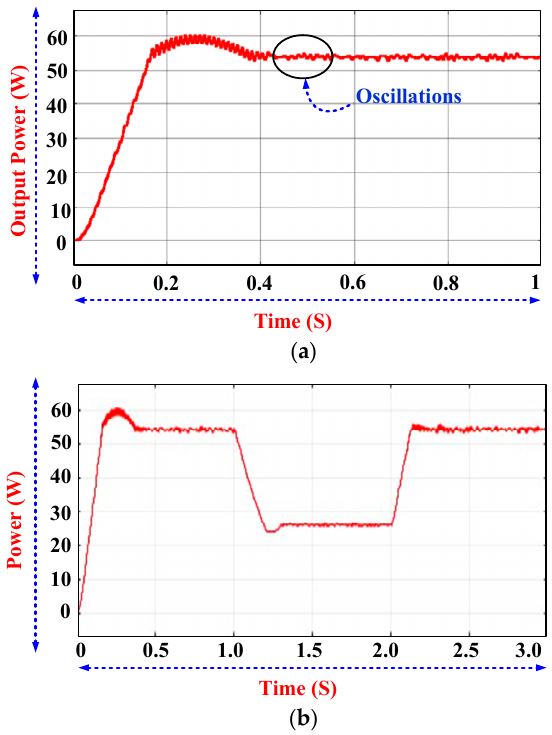
Figure 14. Output power from PSO for ( a ) 1000W/m 2 ; ( b ) irradiance is varied from 1000 W/m 2 to 500 W/m 2 at 1 s then increased to 1000 W/m 2 at 2 s.